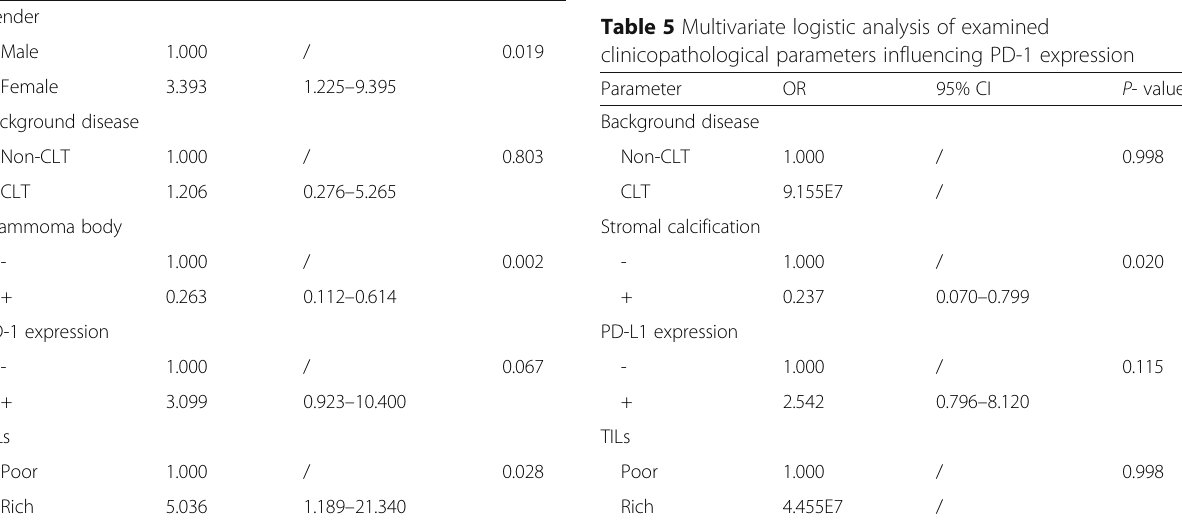
Table 4 Multivariate logistic analysis of examined clinicopathological parameters influencing PD-L1 expression Parameter